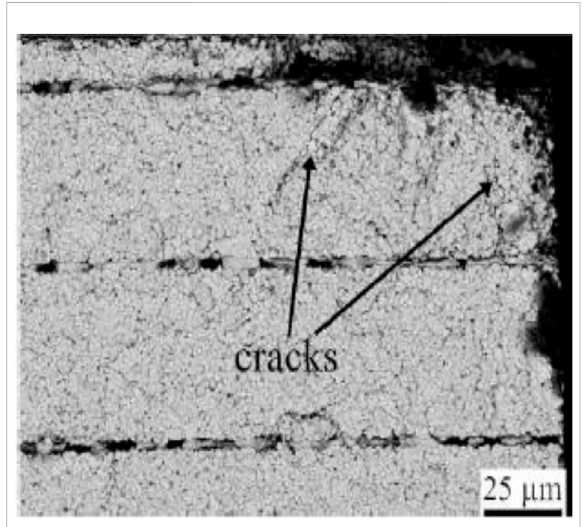
FIGURE 1 Scanning electron microscopic view of the fractured surface of the poled multilayer PZT ceramic composite reproduced from the study by Bermejo et al.